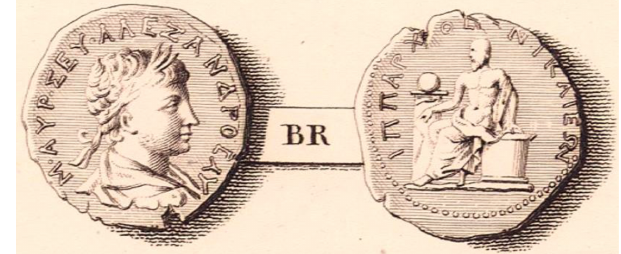
Figure 16. (Hipparchus of Nicaea; c. 190– founder of trigonometry and discoverer of the precession of the equinoxes. Hipparchus is depicted in the back facet of a